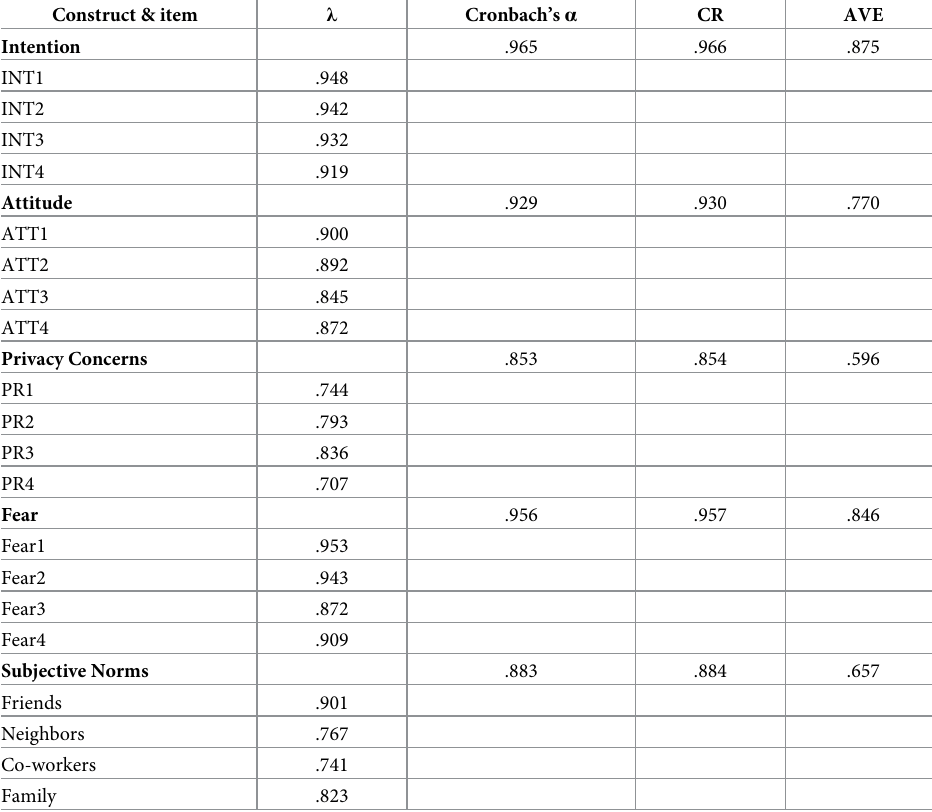
Table 4. Measurement model convergent validity statistics (standardized regression